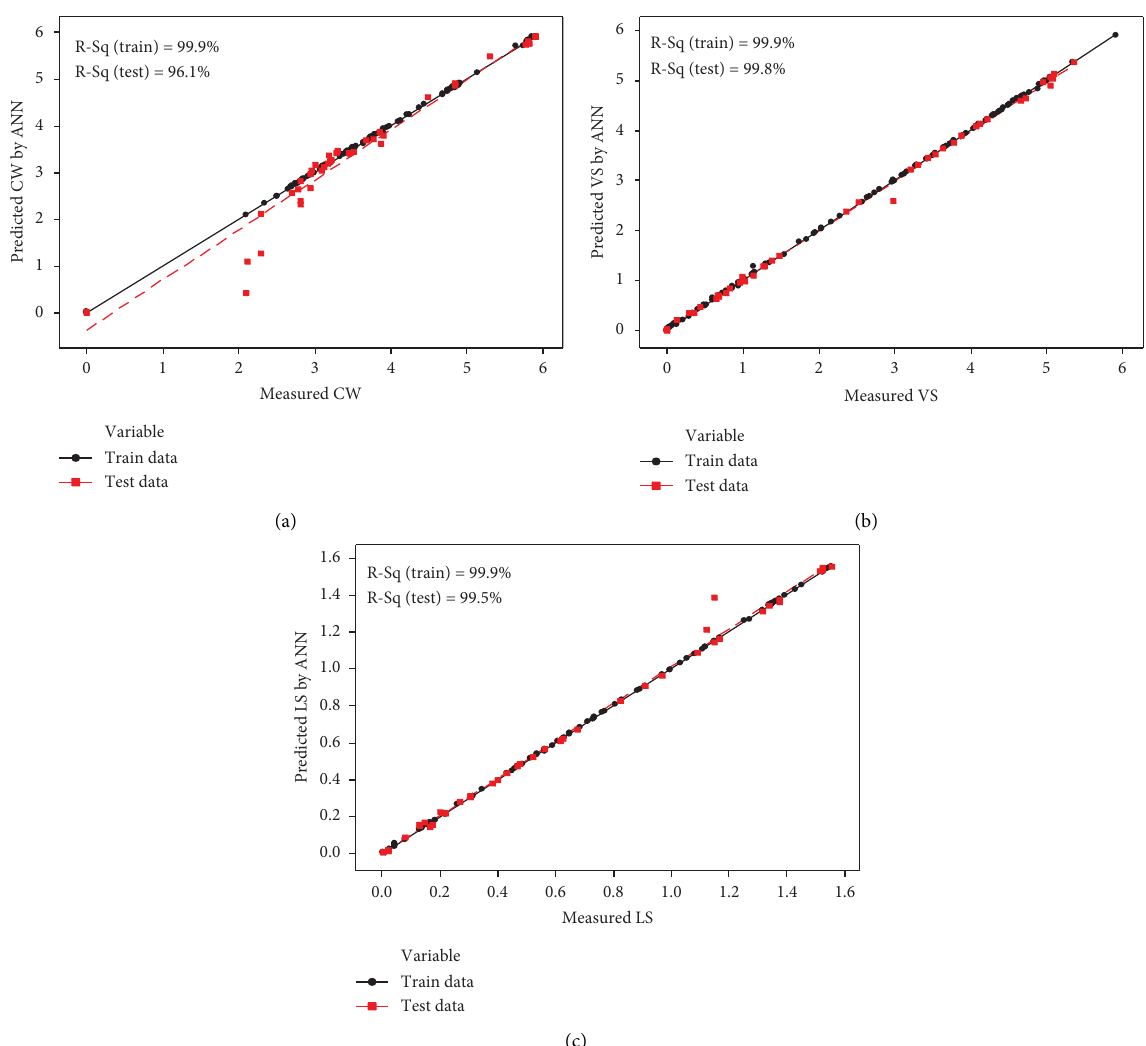
Figure 17: The values of R-squared for ANN models. (a) Crack width (CW), (b) volumetric shrinkage (VS), and (c) linear shrinkage (LS).